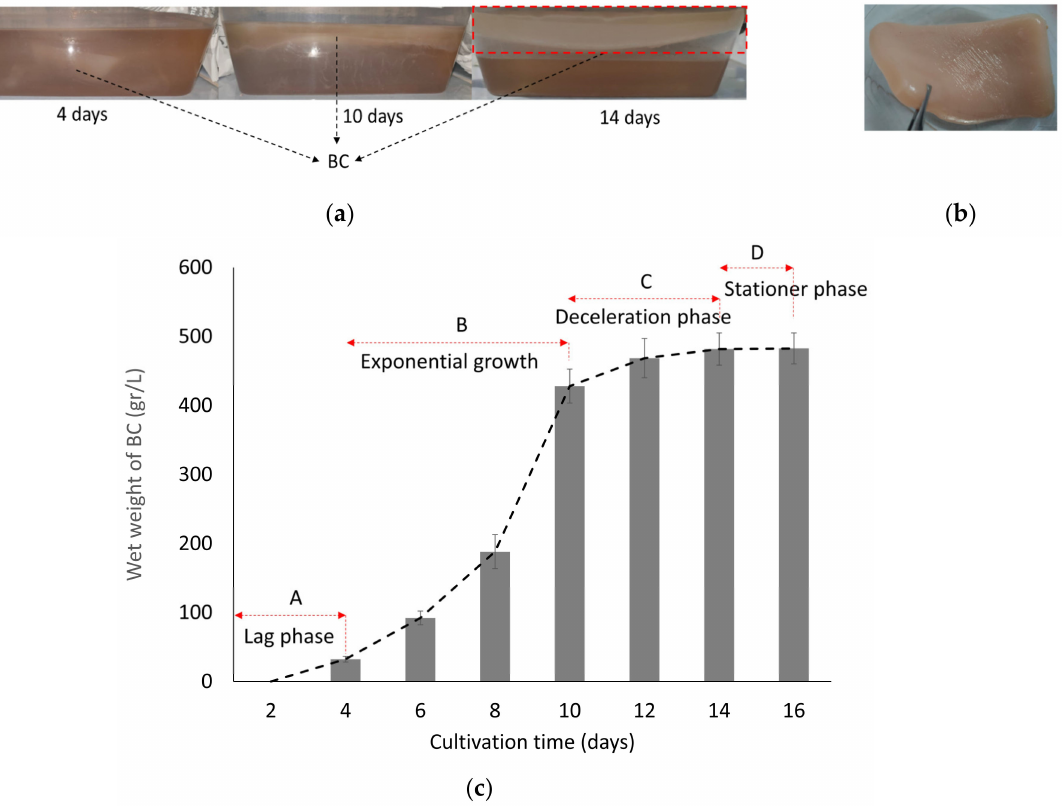
Figure 1. ( a ) The growth of BC during incubation, ( b ) the BC product after purification; ( c ) the wet weight of BC with a sucrose addition of 200 g/L and an initial medium pH of 4.5. During incubation, the BC morphology transformed from a floccus to a